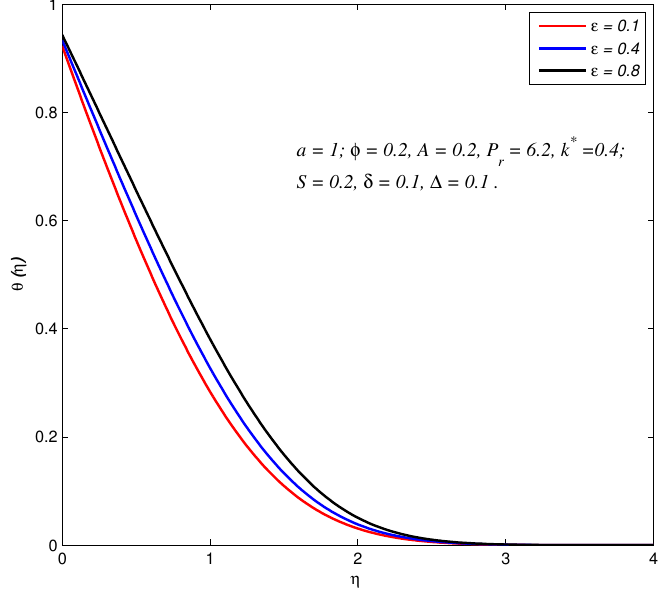
Figure 10. Temperature θ ( η ) profiles for different values of (cid:101)